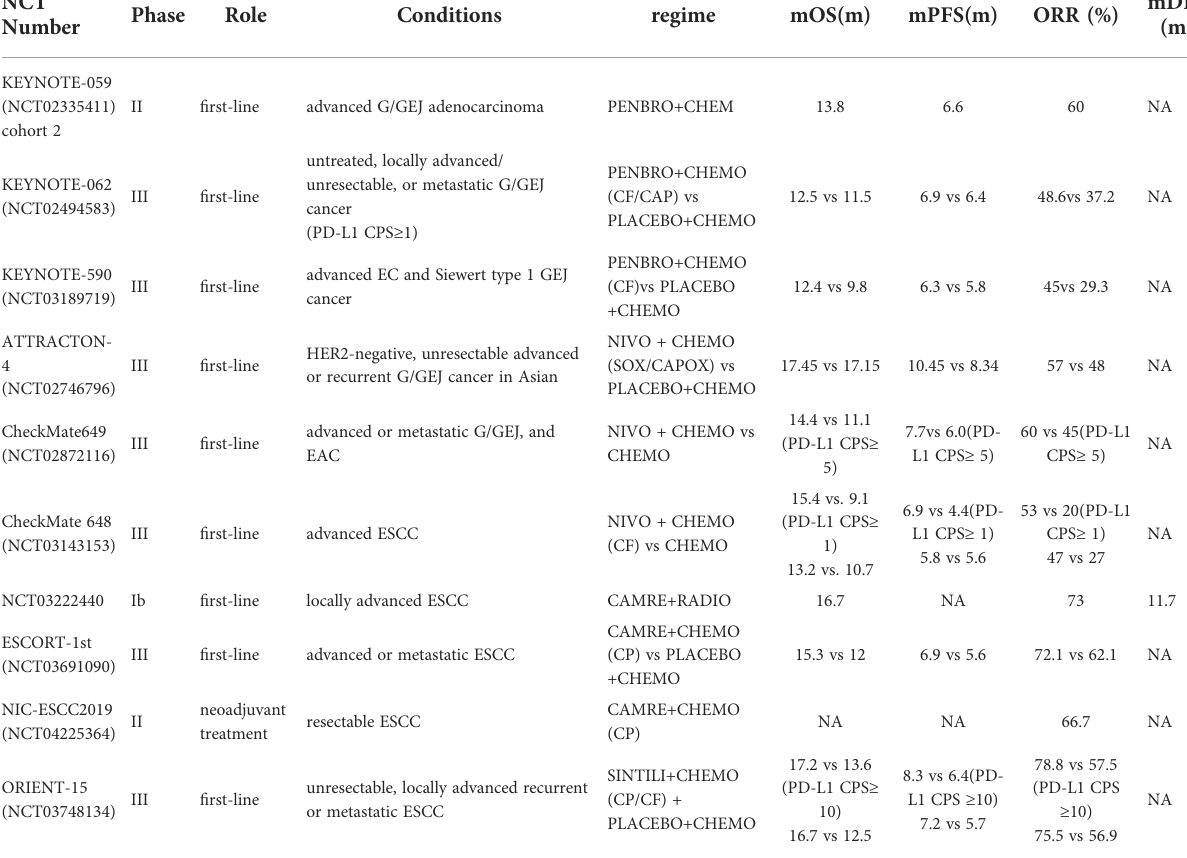
TABLE 1 Clinical Trial of Immunotherapy in Combination with